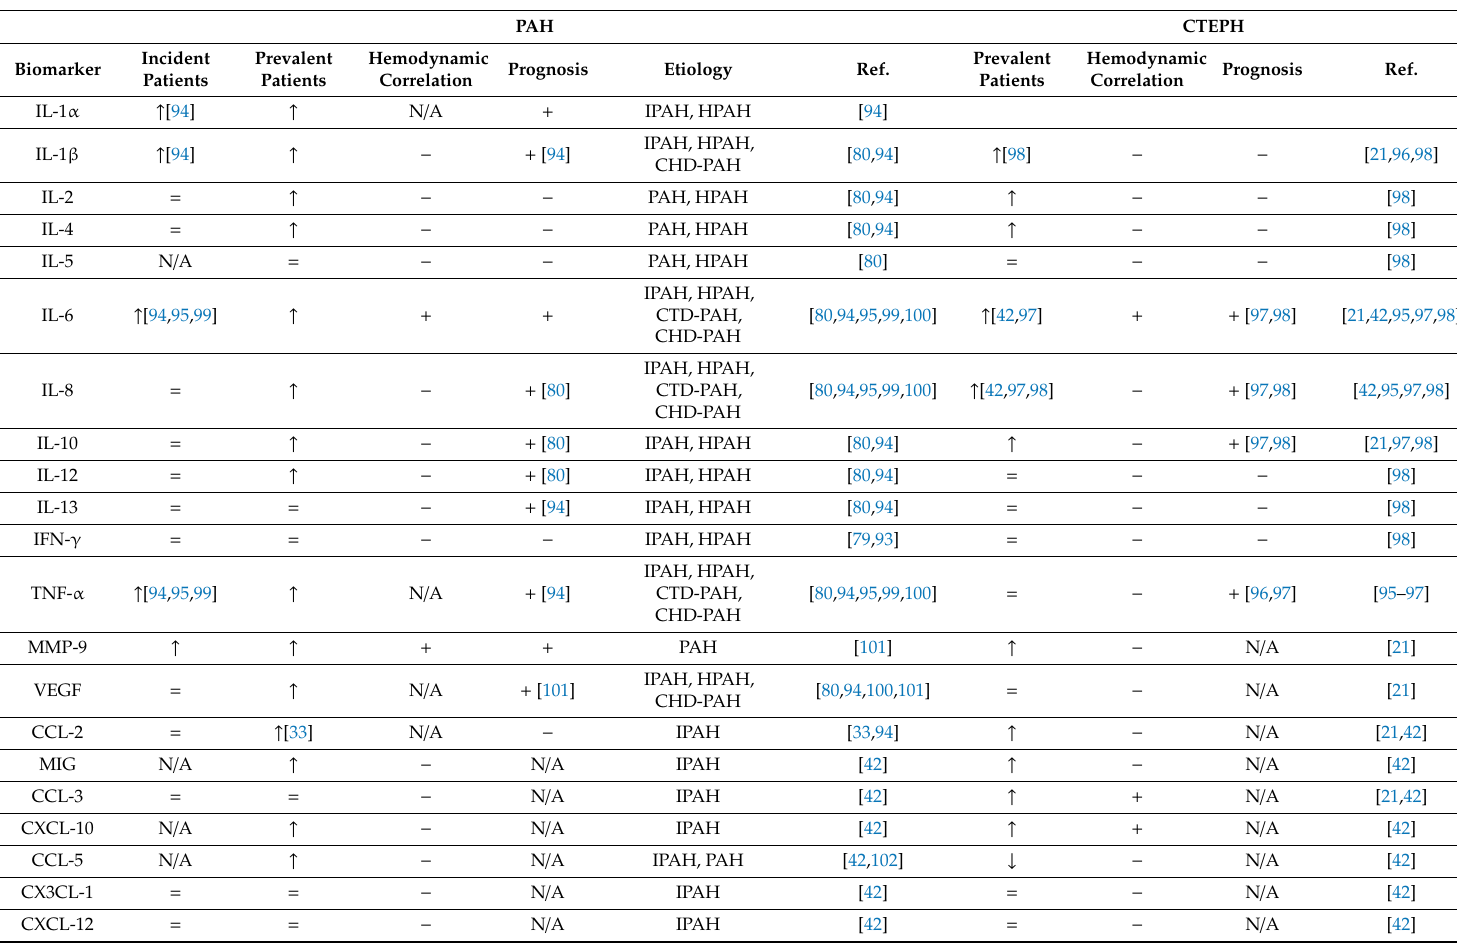
Table 1. Circulating cytokine / chemokine Levels in patients with pulmonary arterial hypertension or chronic thromboembolic pulmonary hypertension. PAH CTEPH Incident Prevalent Hemodynamic Biomarker Prognosis Etiology Ref. Patients Patients Correlation